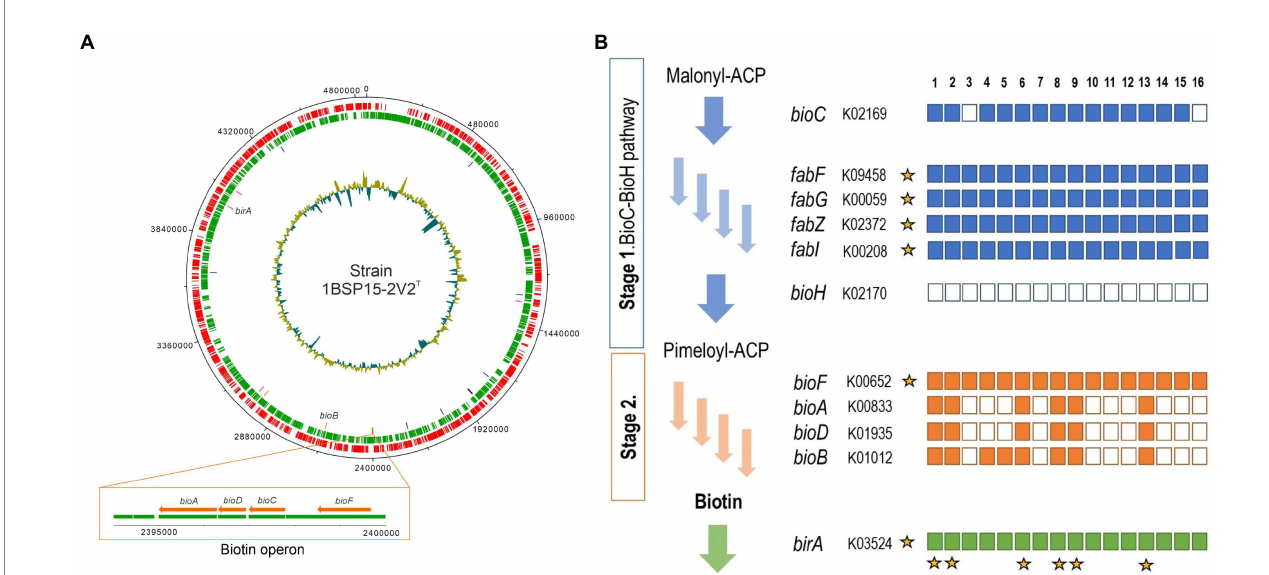
FIGURE 8 (A) Circular genome map of strain 1BSP15-2V2 T annotated by Prokka. The graph was generated with “DNAPlotter” (Carver et al., 2009). Circles indicate, from outside inwards: coding sequences in the leading strand (red); coding sequences in the lagging strand (green); coding sequences related to the biotin biosynthesis; G + C content. Biotin pathway-related genes are displayed in colors: stage 1 of biosynthesis, blue; stage 2 of biosynthesis, orange; regulation and transport, pink. A diagram of the biotin operon arrangement is shown in the box. Genes bioA , bioD , bioC , and bioF are located in the same region of the genome with a hypothetical protein encoded between bioF and the rest of the bioADC genes. The organization in form of operon allows the cotranscript of their proteins in the correct stoichiometry (Sirithanakorn and Cronan, 2021). bioB and birA genes are placed in a different region of the chromosome. (B) Biotin biosynthesis pathway for members of the family Balneolaceae . Although almost the complete BioC-BioH pathway was detected in most of the genomes, bioH gene was missing for all of them. Stars indicate either that the gene is present in all the genomes or that the pathway (except bioH gene) is complete for the corresponding genome. 1. Strain 1BSP15-2V2 T ; 2. Aliifodinibius halophilus 2W32 T ; 3. Aliifodinibius roseus DSM 21986 T ; 4. Aliifodinibius salicampi KACC 19060 T ; 5. “ Aliifodinibius salipaludis ” WN023 T ; 6. Aliifodinibius saliphilus ECH52 T ; 7. Aliifodinibius sediminis DSM 21194 T ;